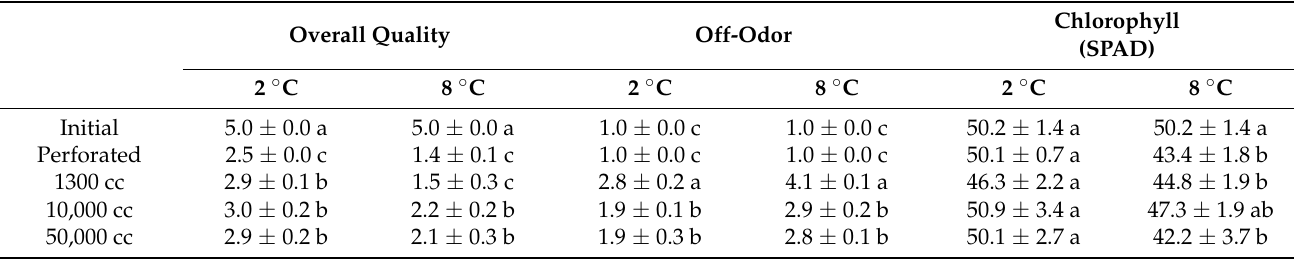
Table 2. The overall quality, off-odor, and chlorophyll content of whole romaine lettuce in OTR film in MA storage at 2 and 8 °C for 15 days.